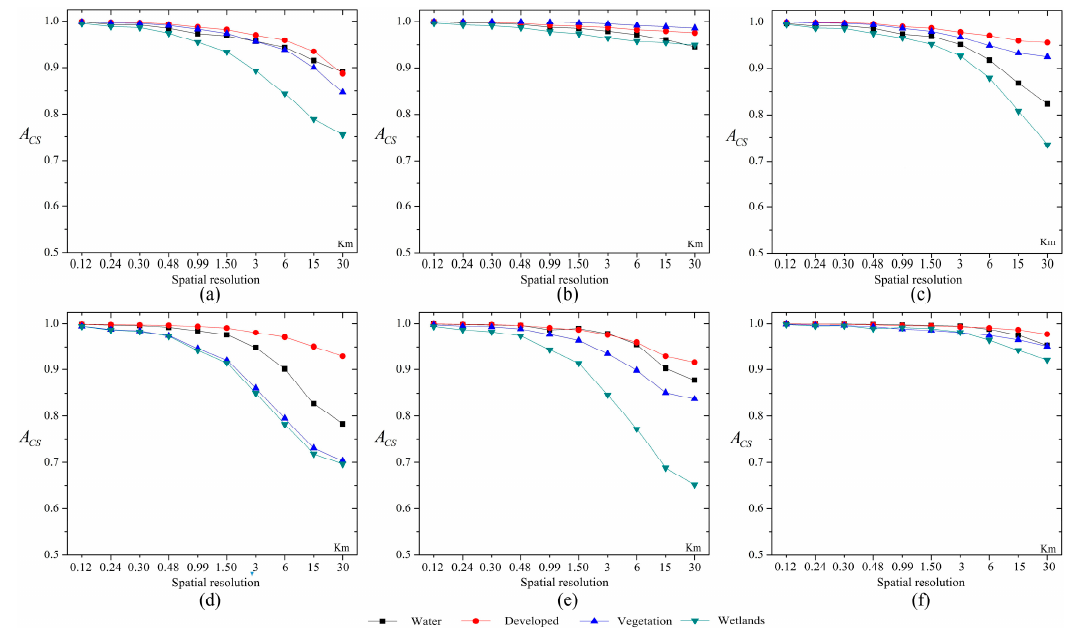
Figure 10. The A cs values during 2001–2006 for different land cover classes with the four-class scheme. ( a – f ) Represent the results of the study areas A to F, respectively.